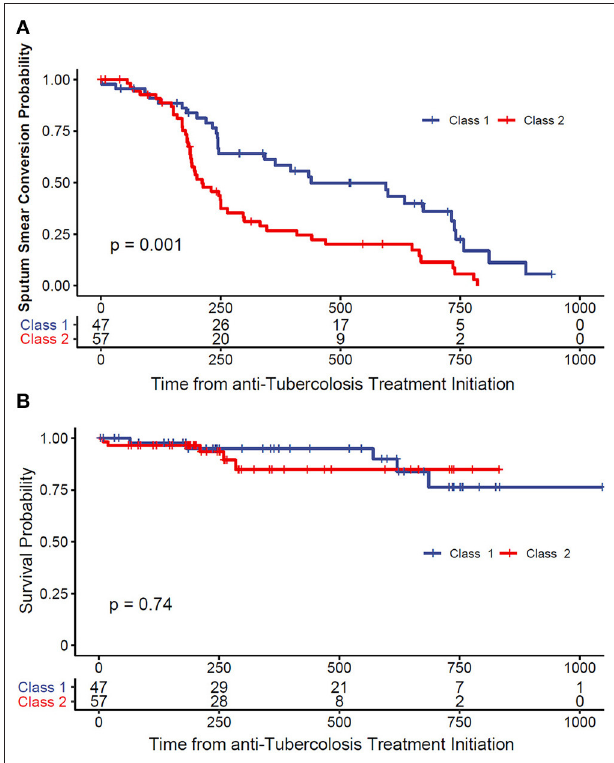
FIGURE 2 | (A) Kaplan–Meier survival curve of time to smear conversion. (B) Kaplan–Meier survival curve of all-cause